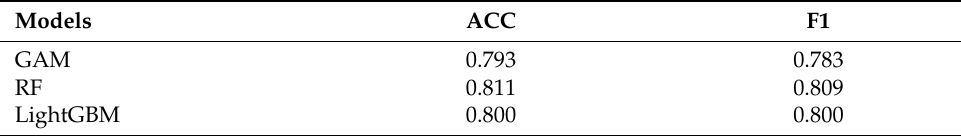
Table 4. Predictive performance of models on the validation set.